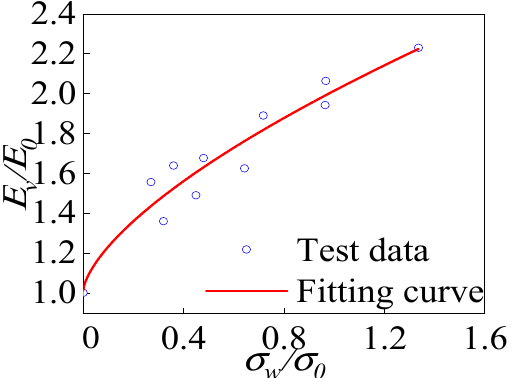
Figure 21. Relationship between the amount of polypropylene fibers addition and the average peak strain.